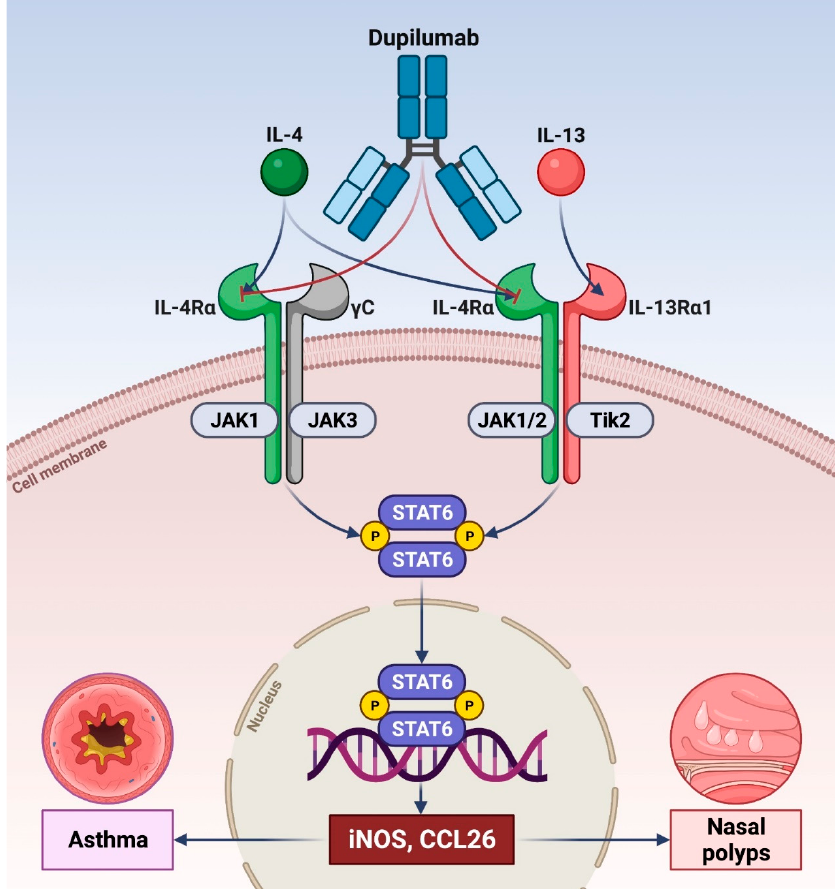
Figure 1. IL-4/IL-13 dual receptor blockade by dupilumab. Dupilumab is a fully human monoclonal antibody which binds to the α subunit of the IL-4 receptor, thus blocking at the receptor level the biological effects of IL-4 and IL-13, which activate a JAK/STAT-mediated signaling network involved in the pathogenesis of type 2 airway inflammation underlying asthma and nasal polyposis. IL-4R α : α subunit of IL-4 receptor; IL-13R α 1: α 1 subunit of IL-13 receptor; JAK: Janus kinase; STAT: signal transducer and activator of transcription; iNOS: inducible form of nitric oxide synthase; CCL 26: eotaxin − 3. This original figure was created by the authors using